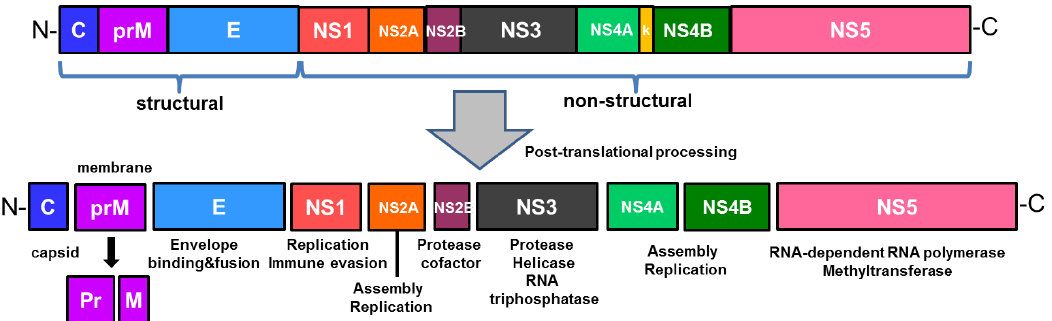
Figure 1. The structure of Zika virus (ZIKV) genome and its encoded proteins. The single open reading frame encodes a polyprotein precursor that is post-translationally cleaved into three structural proteins (capsid, membrane and envelope) and seven nonstructural proteins (NS1, NS2A, NS2B, NS3, NS4A, NS4B, and NS5).